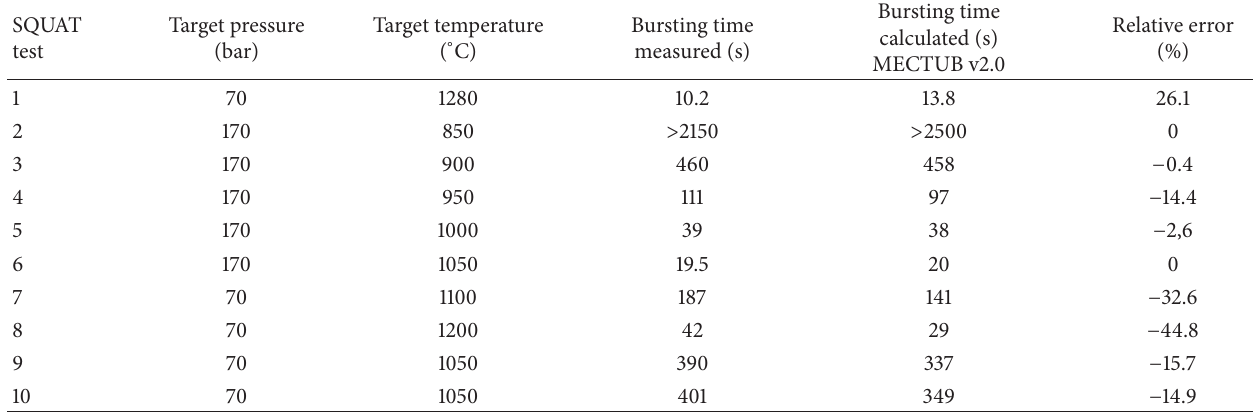
Table 4: Comparison of rupture time of the 9% Cr with the experimental measures SQUAT.